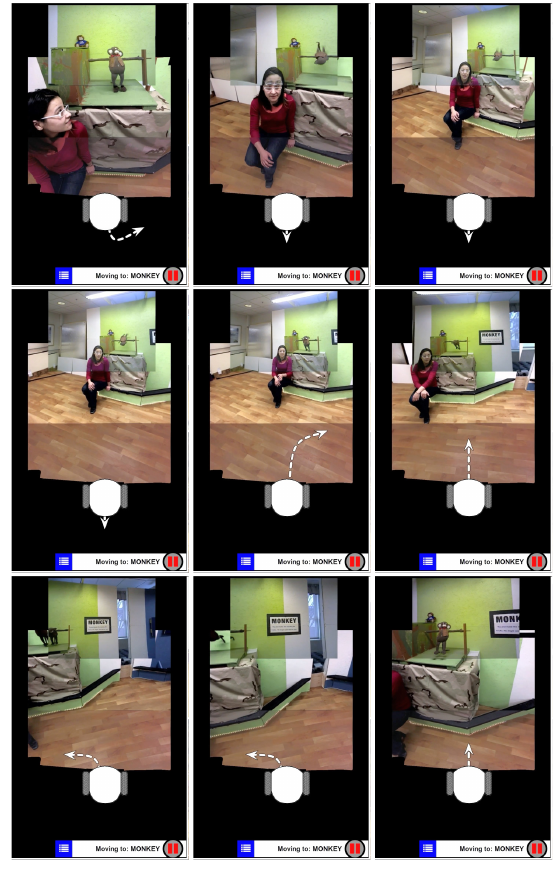
Fig. 6. When moving from monkey’s center hotspot to its right hotspot, the robot first backs away to the right retreat pose and then moves forward to its alignment point right align , and finally arrives at the hotspot right . The exhibit remains in the robot’s field of view for the duration of this